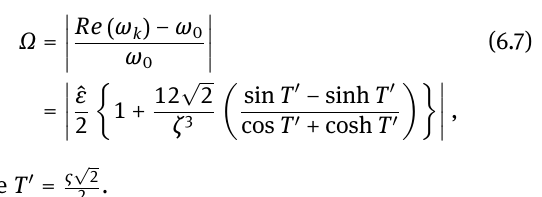
Figure 2: Variation in damping with respect to angular frequency.